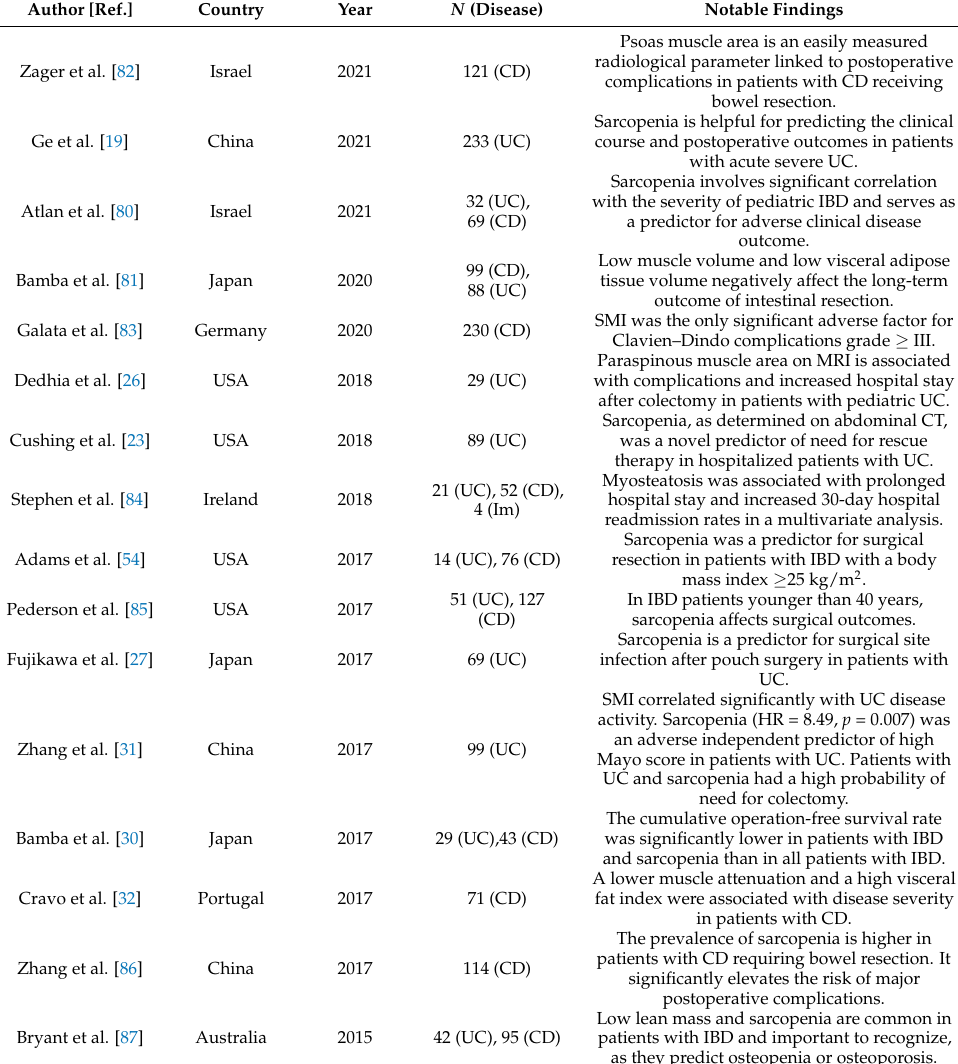
Table 2. Prognostic impact of sarcopenia in patients with inflammatory bowel